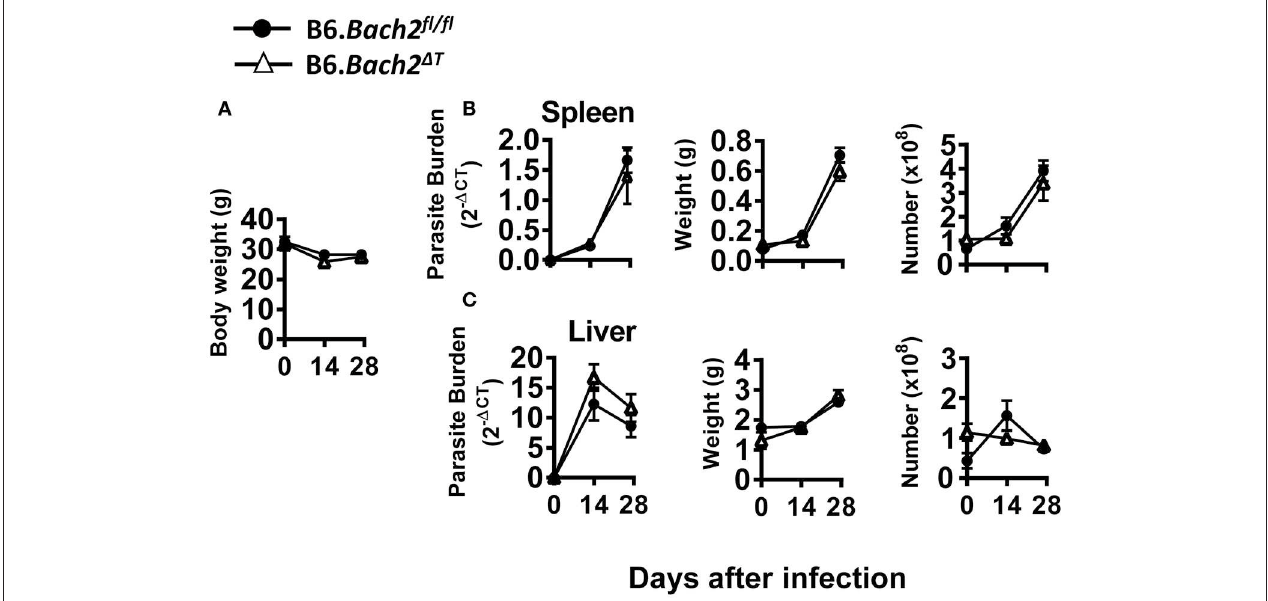
FIGURE 5 | T cell-specific BACH2 deficiency does not influence disease outcome in L. donovani infection. B6. Bach2 ∆ T (open triangles) and B6. Bach2 fl / fl mice (closed circles) mice were infected with L. donovani and assessed for body weight (A) , as well as spleen (B) and liver (C) parasite burden, organ weight and leukocyte number, as indicated, at days 0, 14, and 28 p.i., n = 3–7 mice per group per time point, mean ±